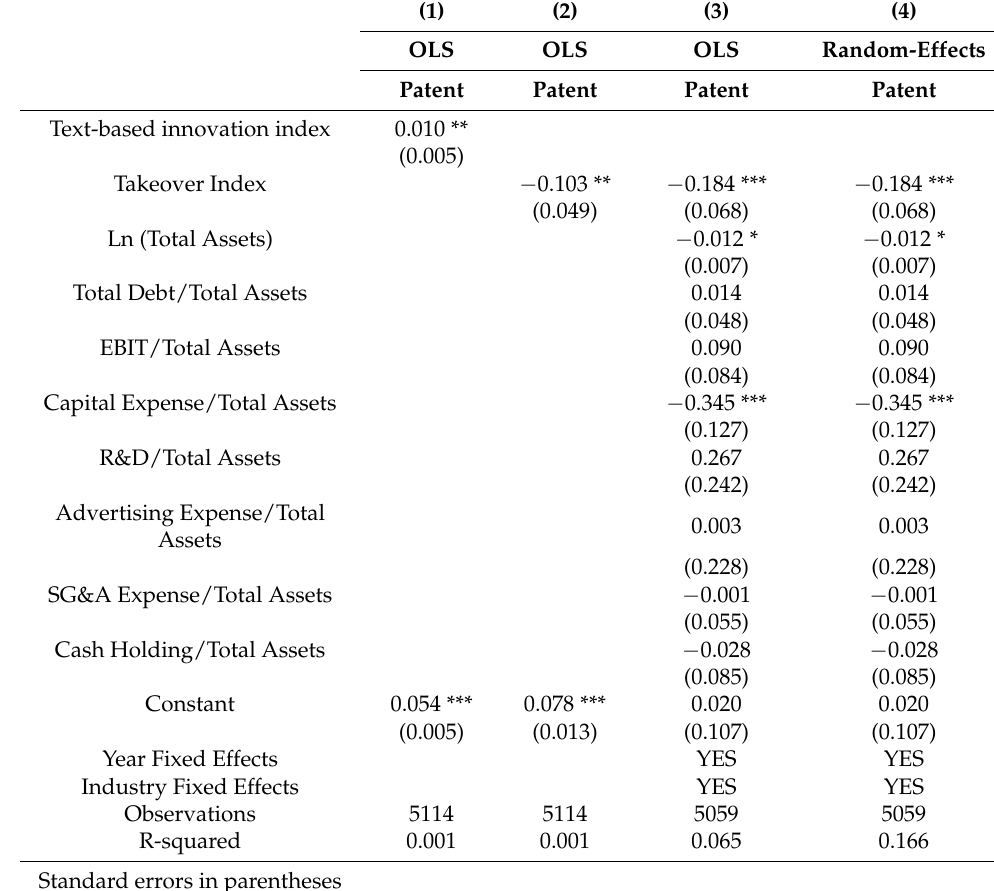
Table 3. The effect of the hostile takeover on the patent as a proxy for corporate